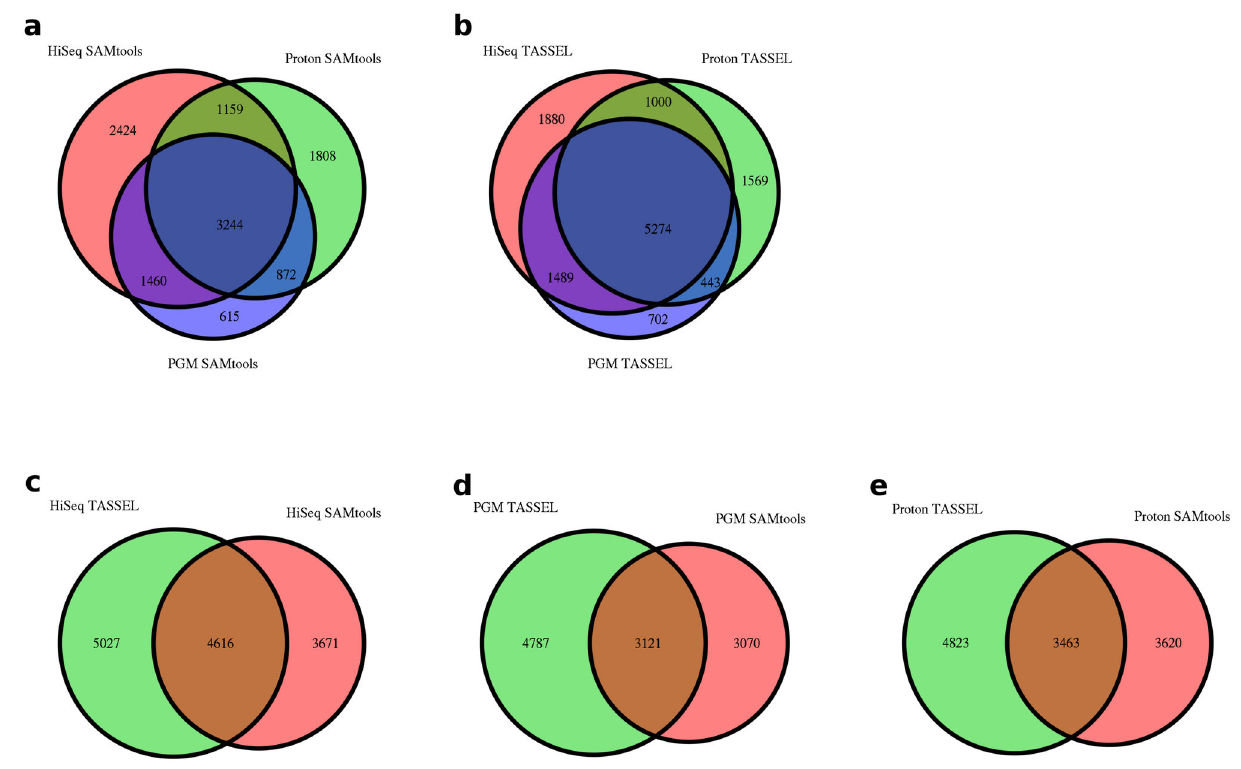
Figure 3. Venn diagrams of the number of SNPs identified in each dataset and with the respective bioinformatics pipeline. ( a ) SNPs identified with the SAMtools pipeline across all three platforms. ( b ) SNPs identified with the TASSEL pipeline across all three platforms. ( c ) SNPs identified in the HiSeq2000 data with both pipelines. ( d ) SNPs identified in the PGM data with both pipelines. ( e ) SNPs identified in the Proton data with both